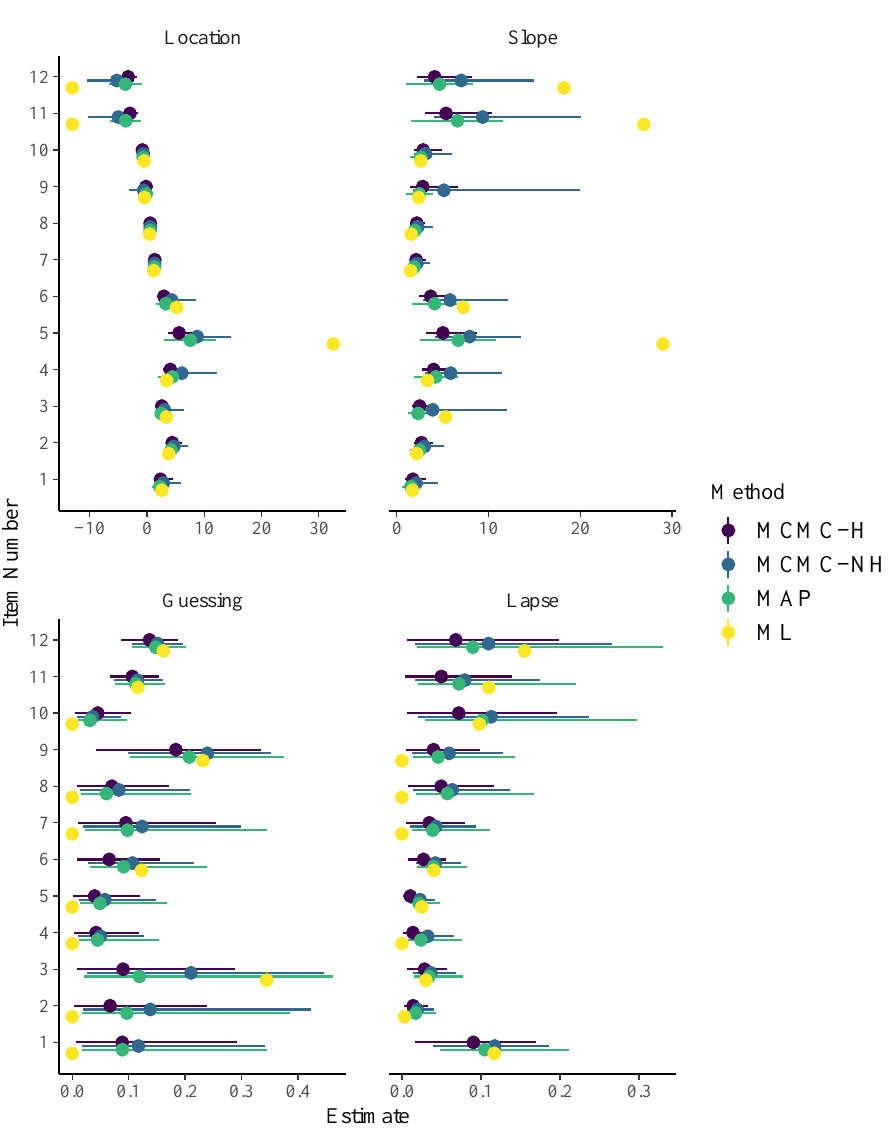
Figure 5. Item parameters of the 4PL model. Horizontal lines indicate 95% uncertainty